Question: What type of chart is this?
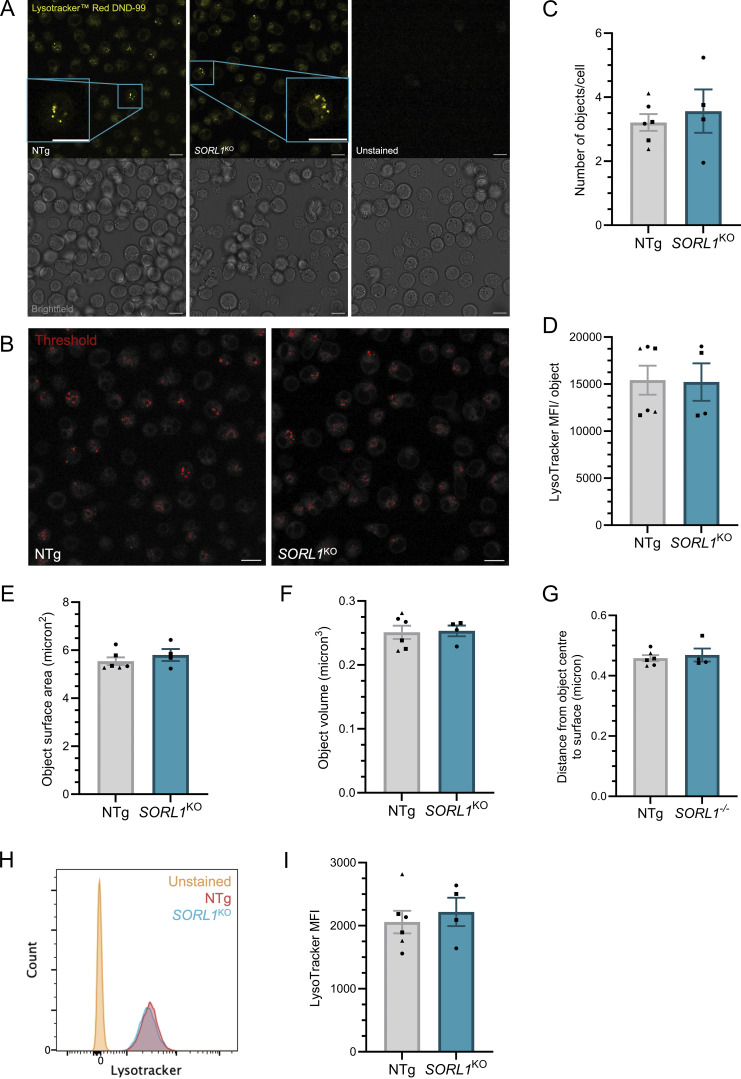
Answer: bar